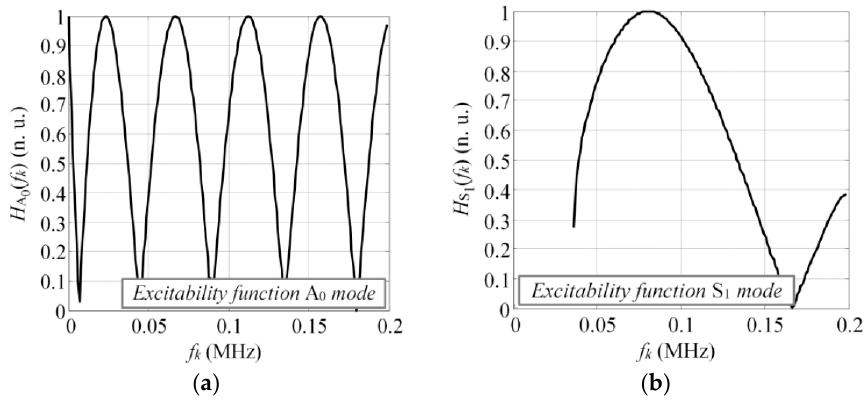
Figure 4. The excitability functions on 4 mm thick GFRP plate for the A 0 ( a ) and S 1 ( b ) modes, calculated according to the spatial distribution of the vertical and longitudinal component of particle velocity.